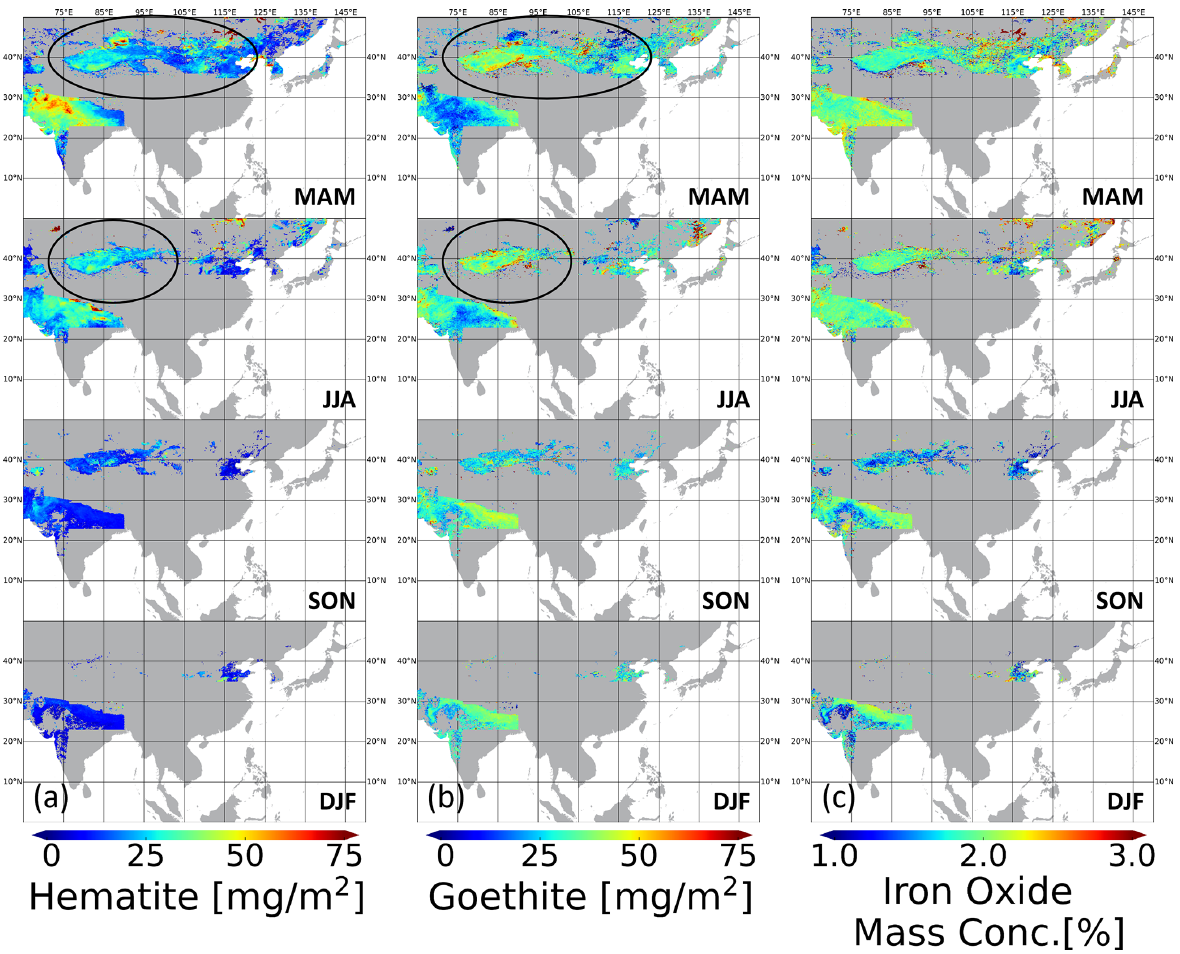
Figure 10. The same as in Fig. 9 but for Asia. Additional data of AOD at 443nm and SSA at 443nm and the total number of data points used in this figure are provided in Fig.